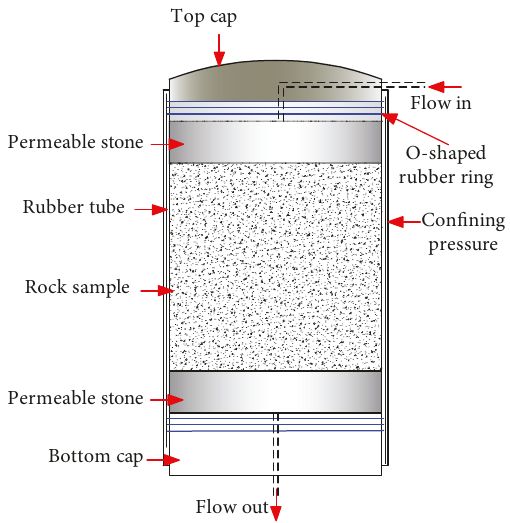
Figure 5: Schematic diagram of rock sample